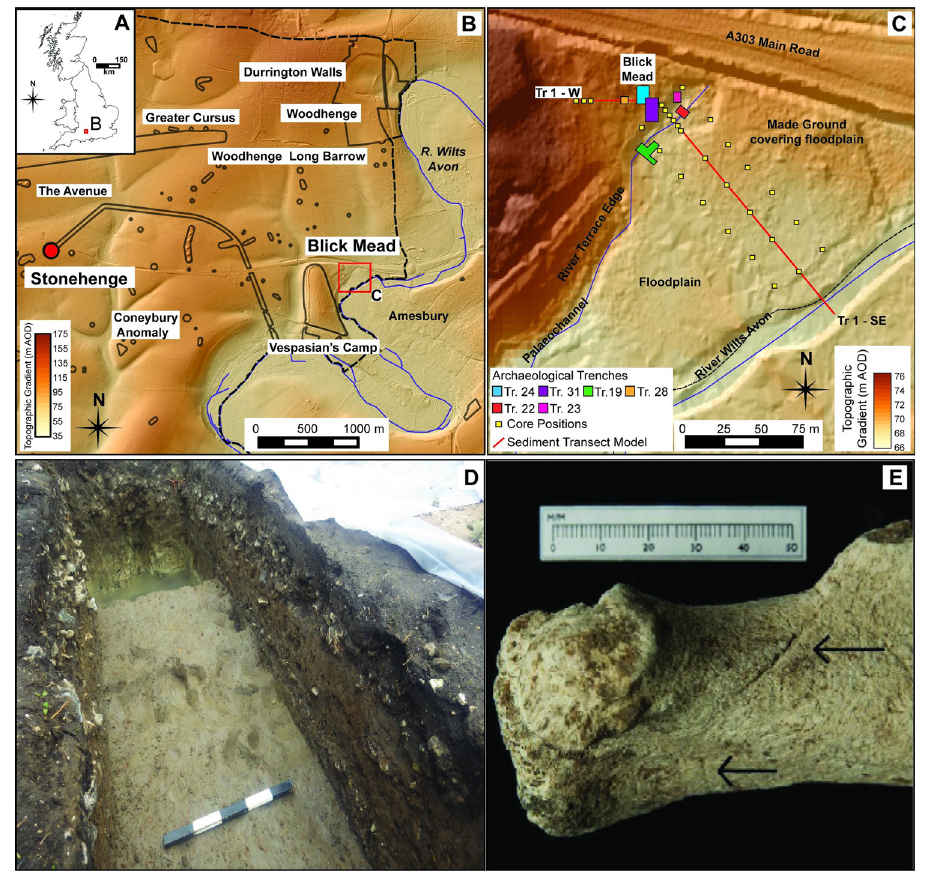
Fig 1. Location, setting and key archaeology. A UK location of the Stonehenge Environs. Map of UK derived from OS open source administrative boundary data © Crown copyright, (Boundary Line 2021). B Eastern section of